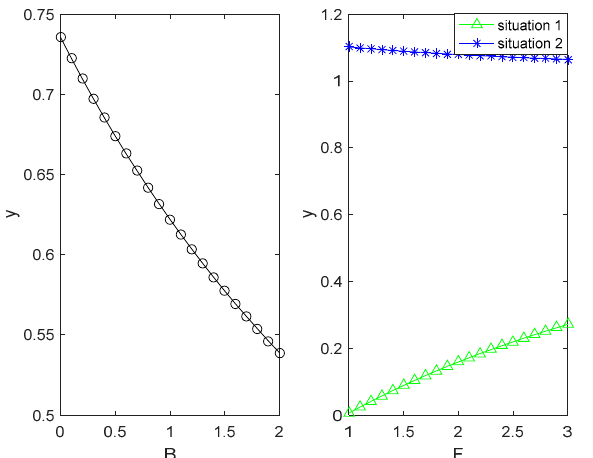
Figure 4. The impact of reward B and punishment F on local governments’ environmental regu- lation strategy supervision behaviour.